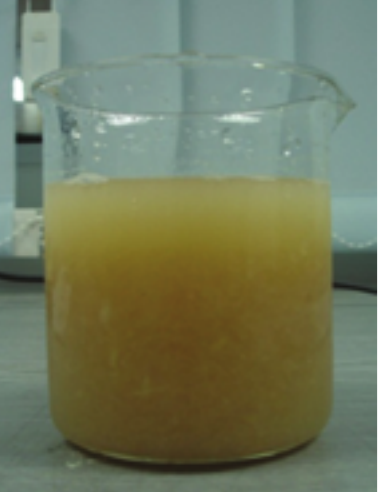
Figure 2: The banana stem